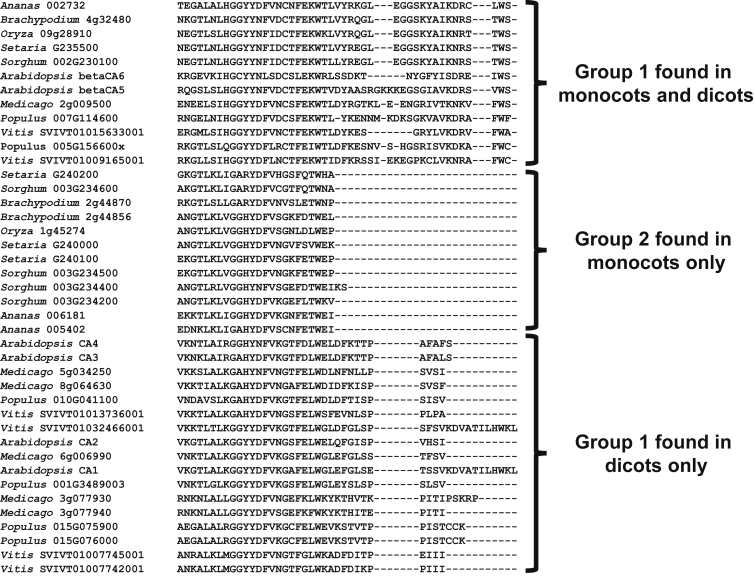
Multiple Sequence Alignment of C-termini of β Carbonic Anhydrase Proteins from Different Plants.Sequences were aligned using Clustal Omega (http://www.ebi.ac.uk/Tools/msa/clustalo/; Sievers et al., 2011). Sequences for Physcomitrella patens (Lang et al., 2005;Rensing et al., 2005, Zimmer et al., 2013), Selaginella moellendorffii (Banks et al., 2011), Medicago truncatula (Young et al., 2011, Tang et al., 2014), Vitis vinifera (Jaillon et al., 2007), Populus trichocarpa (Tuskan et al., 2006, Du et al., 2015, Ye and Zhong, 2015), Brachypodium distachyon (Vogel et al., 2010), Oryza sativa (Ouyang et al., 2007), Setaria italic (Bennetzen et al., 2012), Sorghum bicolor (Makita et al., 2015) were obtained from Phytozome (https://phytozome.jgi.doe.gov). Sequences for Arabidopsis thaliana were obtained from TAIR (Lamesch et al., 2011). Sequences for Ananas comosus were obtained from CoGe (https://genomevolution.org; Ming et al., 2015).